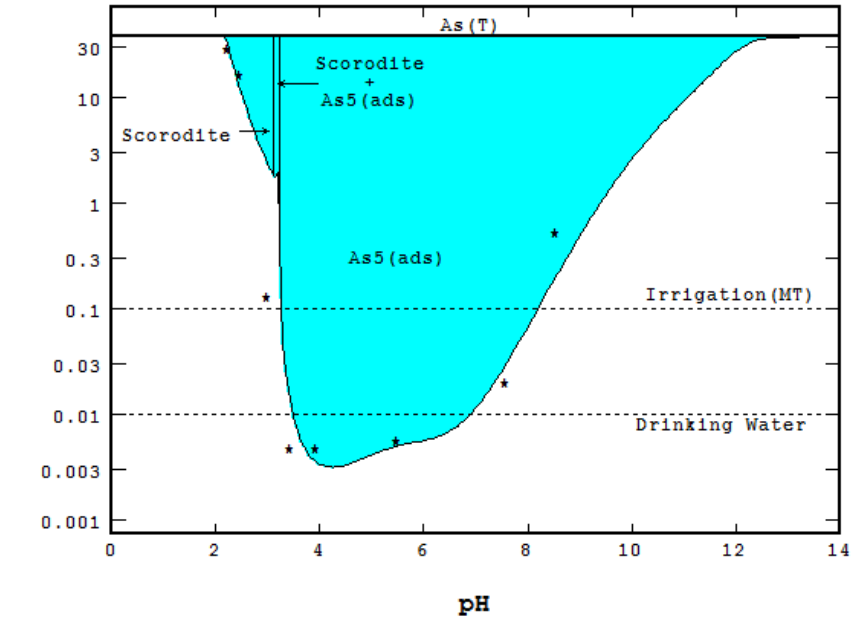
Figure 7. Distribution of As(V) vs. pH diagram when Fe/As = 10. Asterisks are experimentally-observed values. Drinking water standard from EPA (2001).